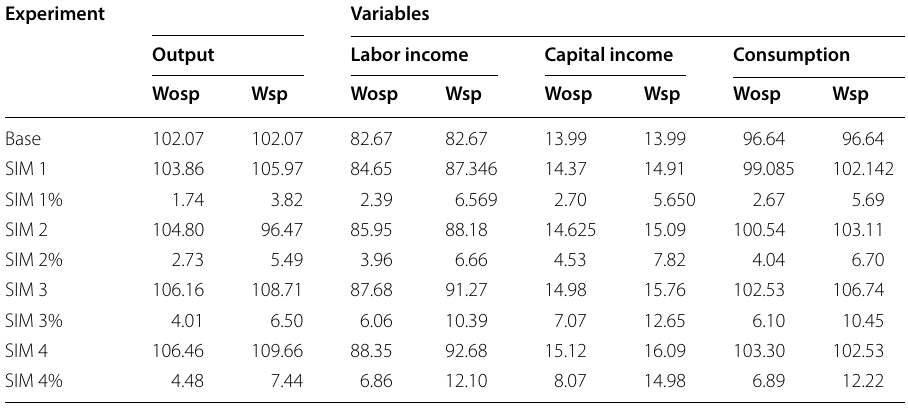
Table 3 The impacts of precision agriculture practices on output, factor income and consumption Source: own computation result based on Oromia region